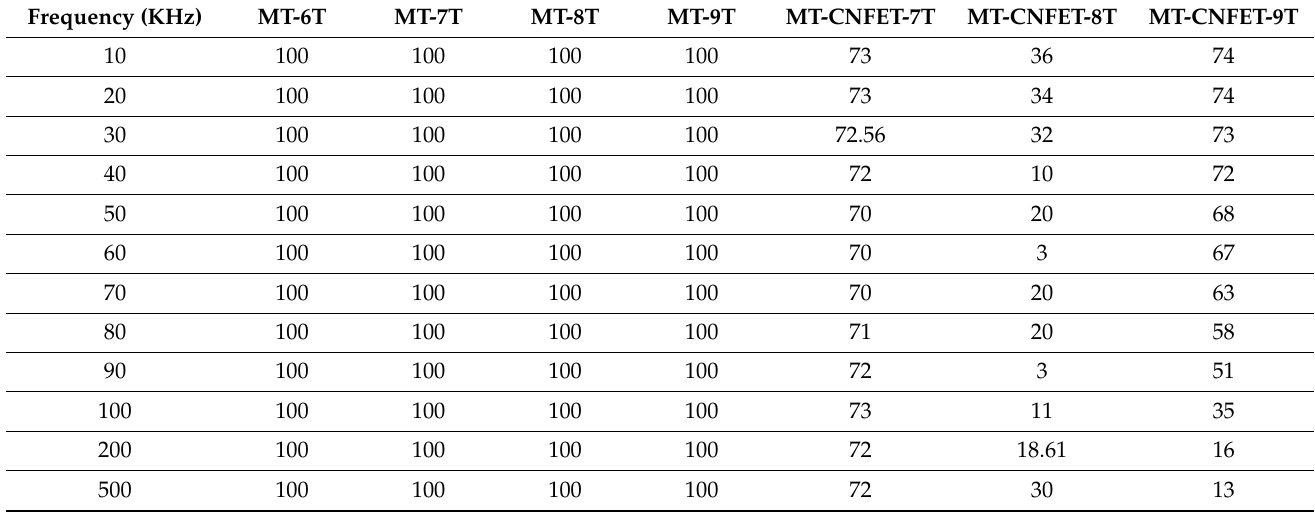
Table 12. Delay Improvement (%)–Proposed MT- CNFET 6T SRAM Cell vs. Other MT-SRAM Cells.